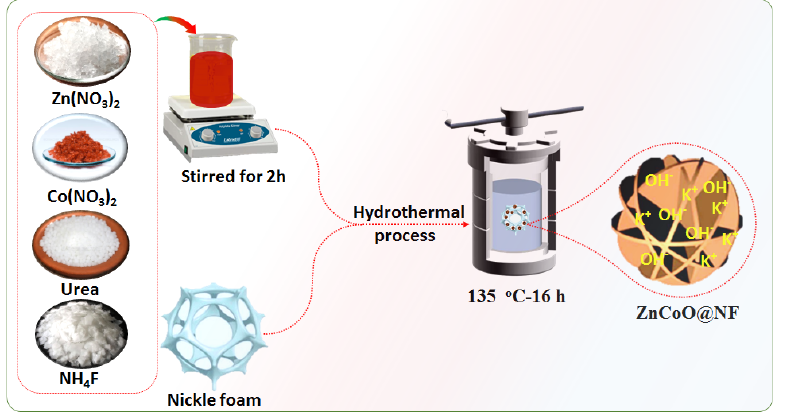
Figure 1. The schematic representation of the synthesis process of ZnCoO@NF through the hydrothermal method.